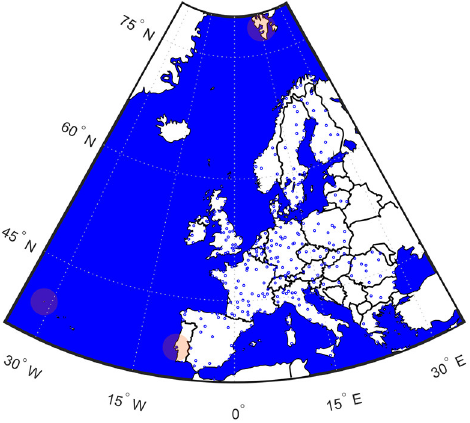
Figure 8. Airports that have no alternate in reach with the specification given in the TLARs.